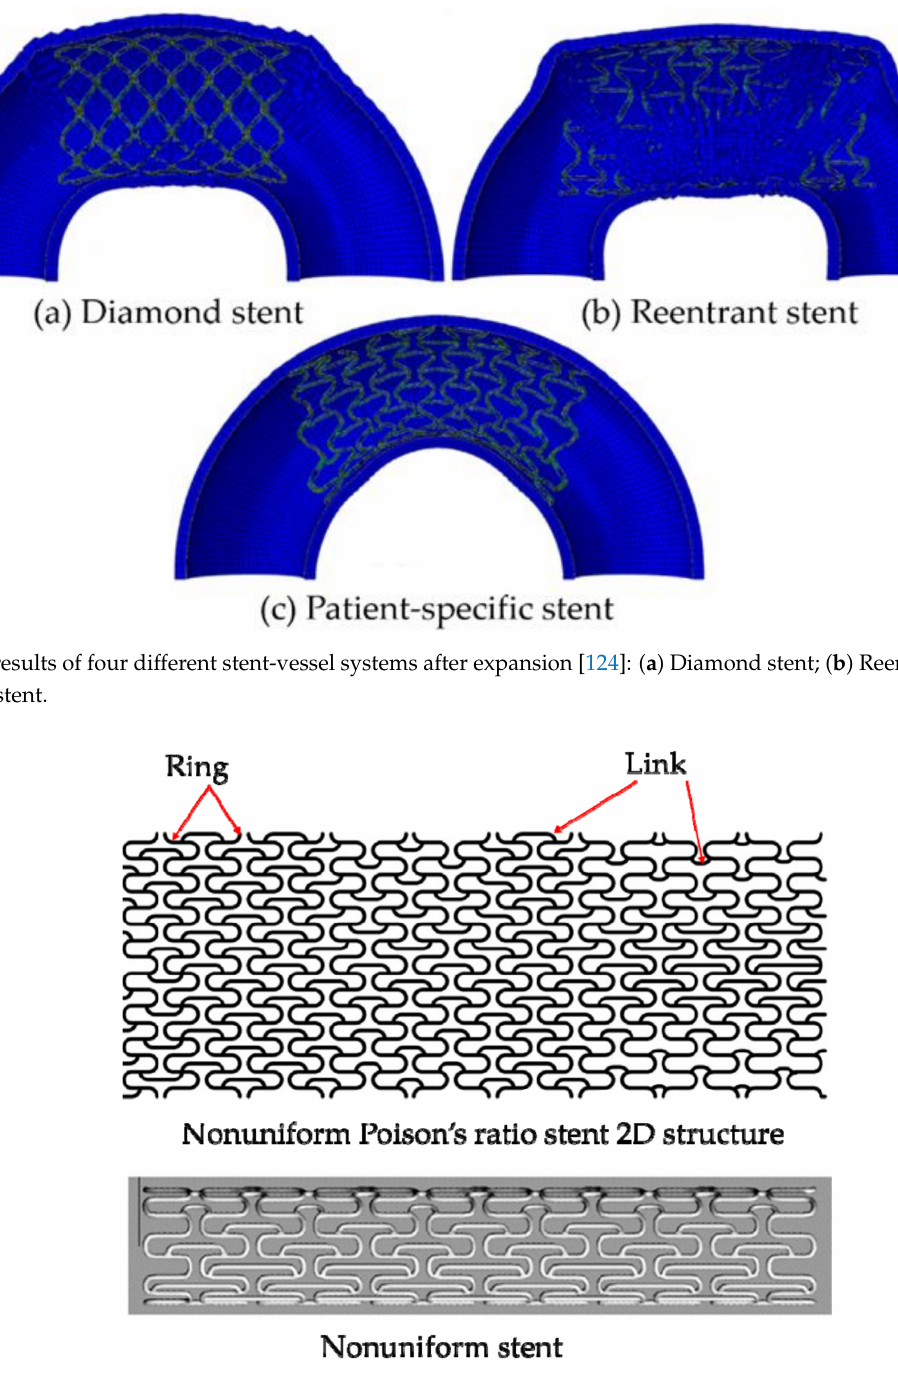
Figure 20. Nonuniform stent